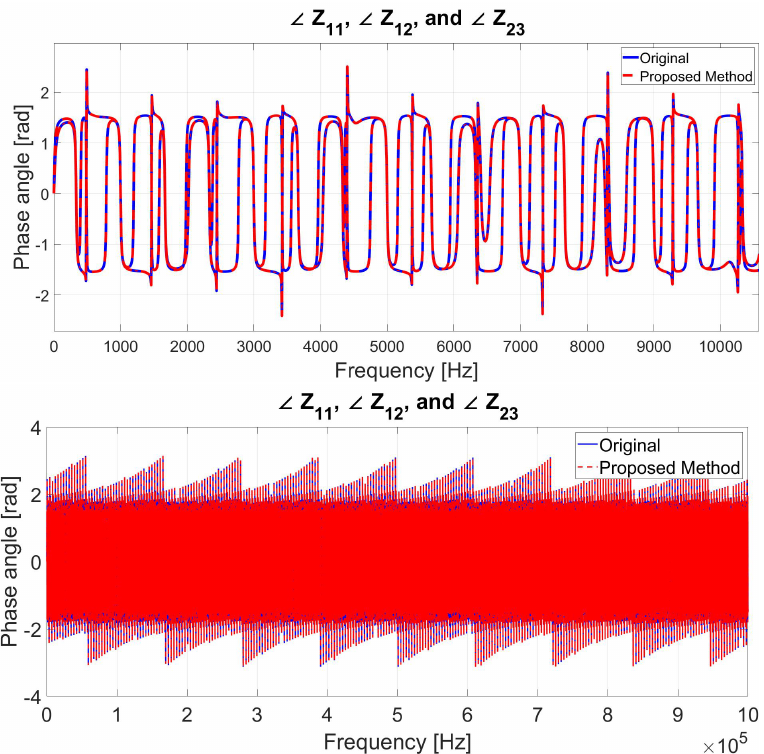
Figure 28. The angle of the measured and fitted impedance using the proposed model, ∠ Z 11 , ∠ Z 12 , and ∠ Z 23 .